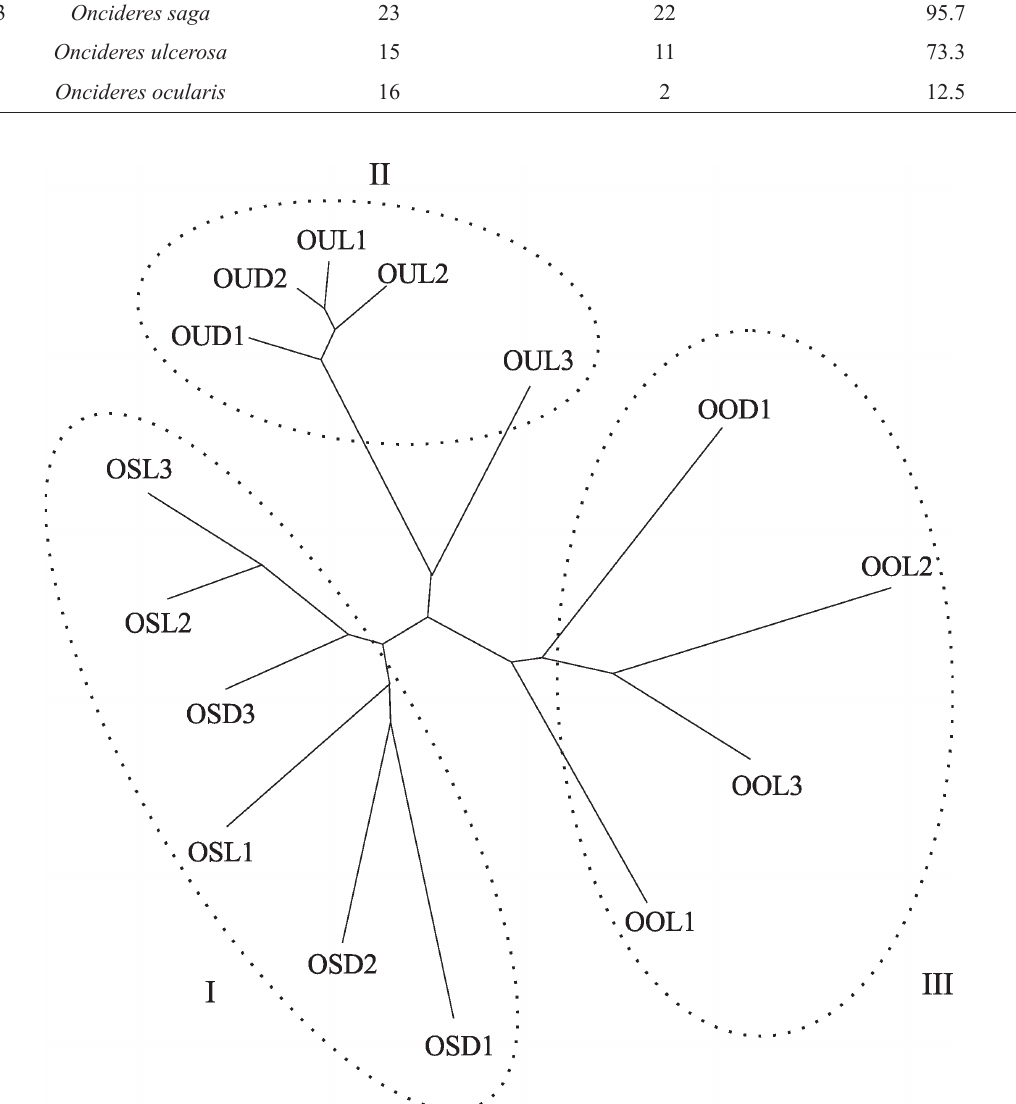
Figure 2 - UPgMA phenogram in the three species of Oncideres . group I: OSD = Oncideres saga adults and OSL = O. saga larvae; group II: OUD = Oncideres ulcerosa adults and OUL = O. ulcerosa larvae; group III: OOD = Oncideres ocularis adults and OOL = O. ocularis larvae